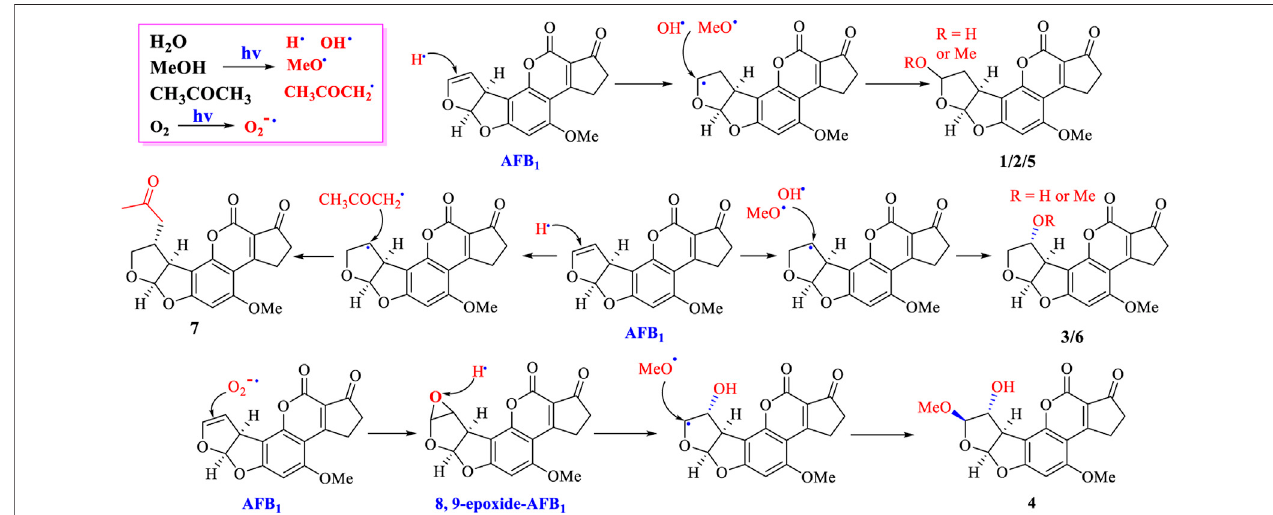
FIGURE 6 | Possibly photocatalytic mechanism of AFB 1 in MeOH and acetone.